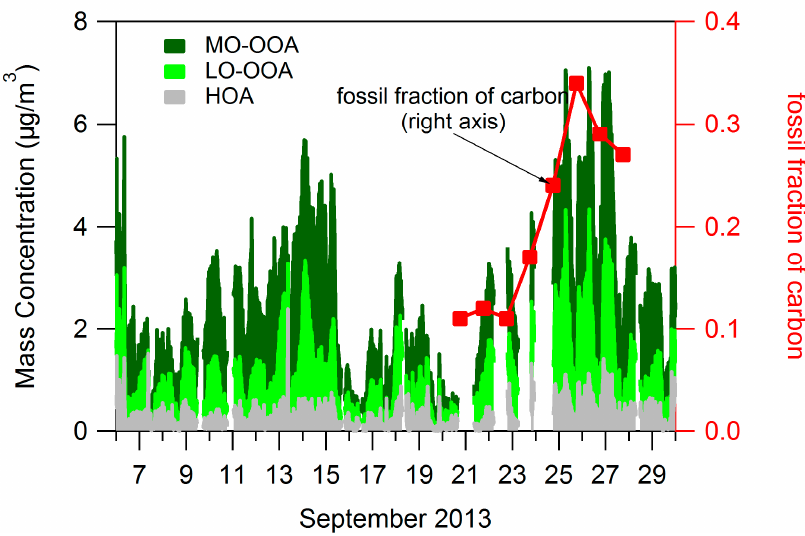
Figure 4. Time series of PMF factors in terms of fractional concentrations.